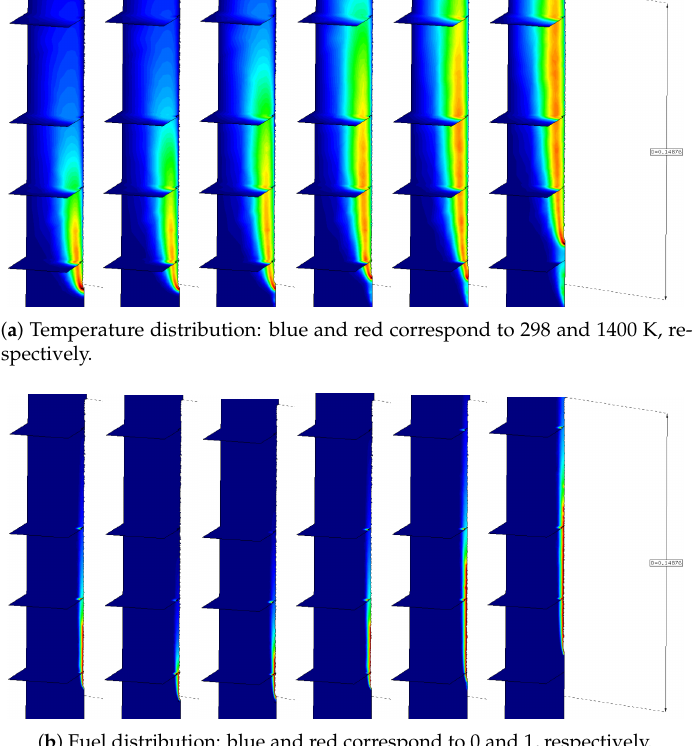
Figure 12. Evolution of the temperature and fuel distribution in the air domain at 10, 20, 30, 40, 50, and 60